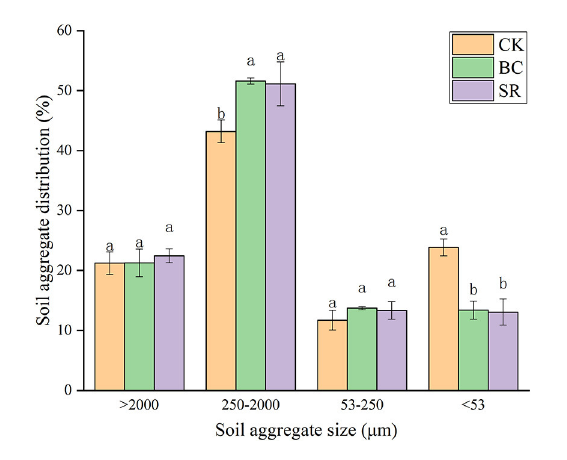
FIGURE2 Effect of maize straw and straw-derived biochar on soil aggregate distribution in Year 2021. The error bars represent the standard deviations of the mean values ( n = 3). Different lowercase letters indicate significant differences between the different